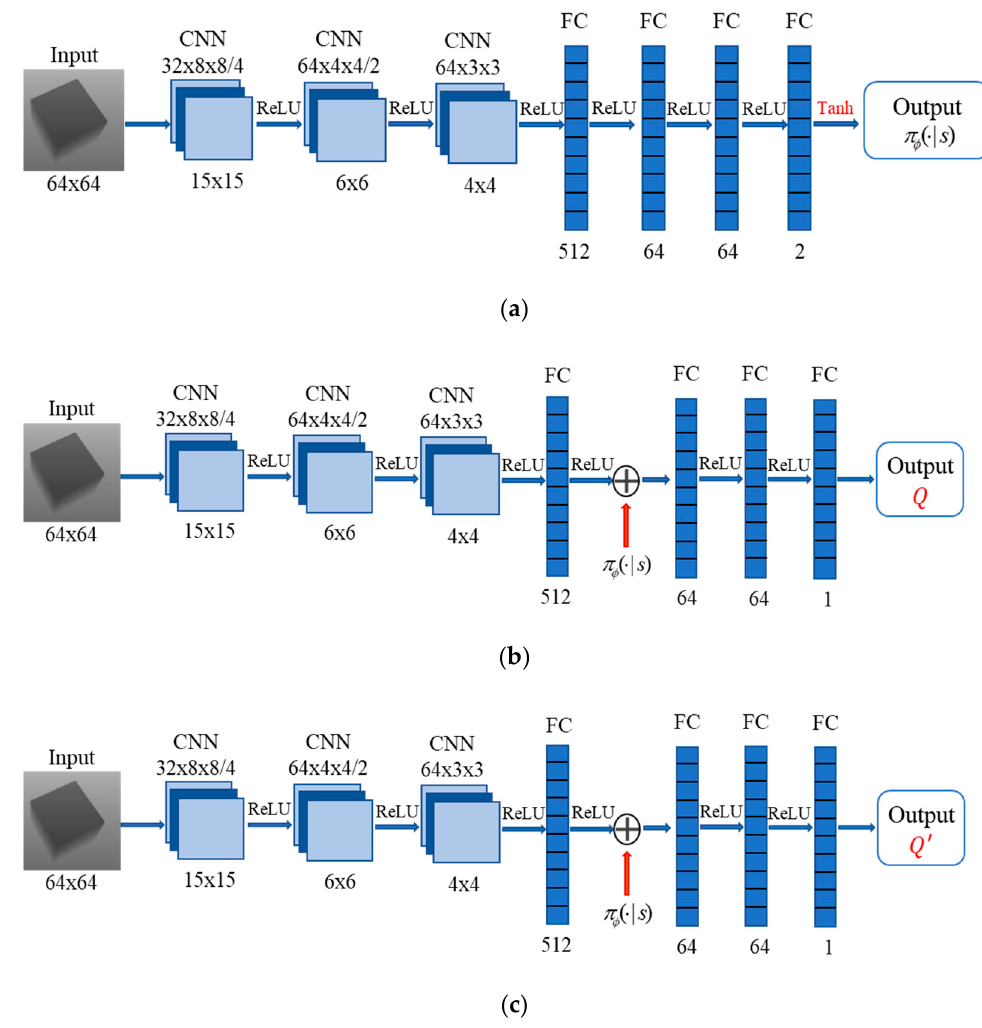
Figure 7. Architecture of SAC neural network. ( a ) Policy Network; ( b ) Soft Action-Value Network; ( c ) Target Soft Action-Value Network.